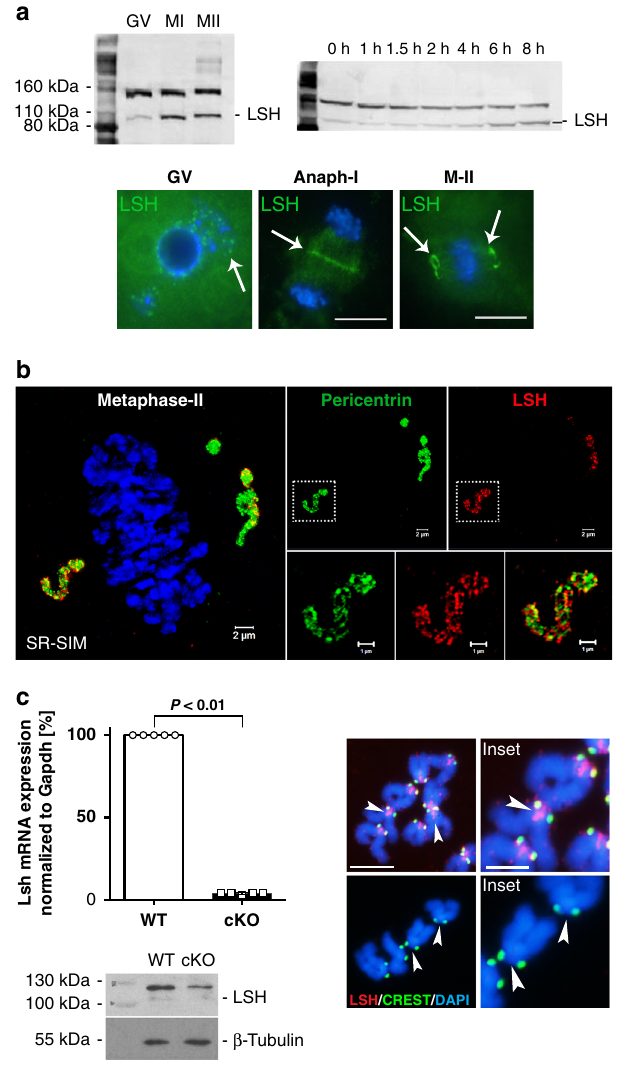
Fig. 4 LSH is present at the meiotic kinetochore and spindle poles during oocyte maturation. a LSH exhibits a dynamic subcellular localization during oocyte meiotic maturation. Western blot detects LSH as a 110 KDa protein in mouse oocytes at the germinal vesicle (GV) stage (100 oocytes/lane). LSH is subject to translational regulation at metaphase-I (M-I) resulting in increased expression levels 6 – 8 h after the onset of GV breakdown. LSH is localized to nuclear speckles (arrow) in GV stage oocytes, but exhibits a dynamic redistribution to the mid-body during anaphase-I and to the meiotic spindle poles in metaphase-II (M-II) stage oocytes. b Super- resolution structured illumination (SR-SIM) resolves the co-localization of LSH (red) with pericentrin (green) at spindle poles in M-II stage oocytes (scale bar = 2 μ m). See insets (scale bar = 1 μ m). c ZP3- Cre oocyte conditional deletion of LSH. Real-time PCR revealed a signi fi cant reduction in LSH transcripts in fully grown conditionally deleted cKO oocytes. Data are expressed as the mean ± SD of fi ve experimental replicates with ( n = 50) wild-type and ( n = 50) cKO oocytes per replicate. Statistical analysis was performed using unpaired t -tests, two tailed and resulted in P < 0.0001. Loss of LSH protein was con fi rmed by western blot. Analysis of chromosomal spreads revealed that LSH is present at the kinetochore and inner centromere domains in metaphase-II stage chromosomes from wild-type oocytes, but is absent from chromosomes of cKO oocytes (scale bar = 5 μ m). Inset scale bar (2 μ